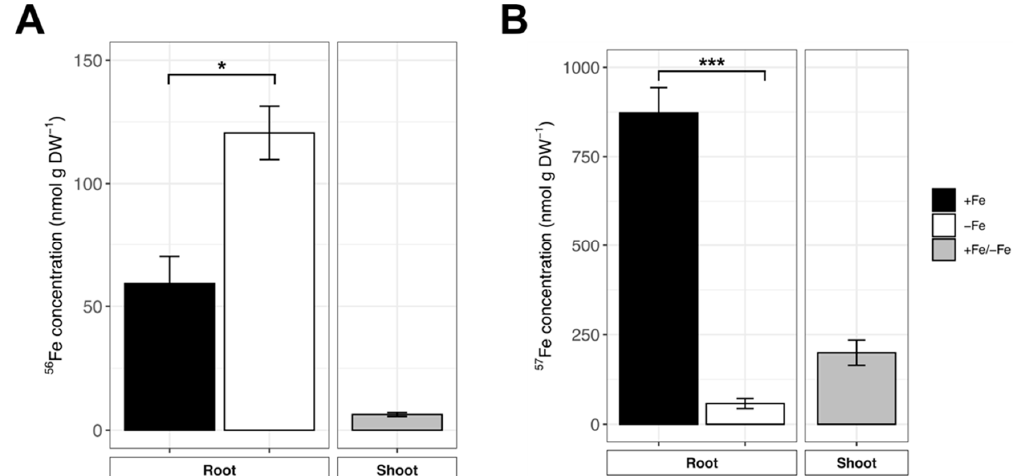
Figure 3. Natural ( 56 Fe) and labelled ( 57 Fe) Fe quantification in tomato split-root plants after Fe 3+ -EDTA resupply: ( A ) 56 Fe quantification in root and shoot tissue of split-root tomato plants at 7 days after the resupply. The resupply was carried out only in one compartment corresponding to the black bars. Data are presented as means ± SE ( n = 3). The statistical significance between resupplied and not-resupplied root compartments was tested by Student’s t -test (*, p < 0.05); ( B ) 57 Fe quantification in root and shoot tissue of split-root tomato plants at 7 days after the resupply. The resupply was carried out only in one compartment corresponding to the black bars. Data are presented as means ± SE ( n = 3). Grey bars (+Fe/-Fe) indicate shoot tissues of plants that were resupplied with 57 Fe only in one root compartment. The statistical significance between resupplied and not-resupplied root compartments was tested by Student’s t -test (***, p < 0.001).